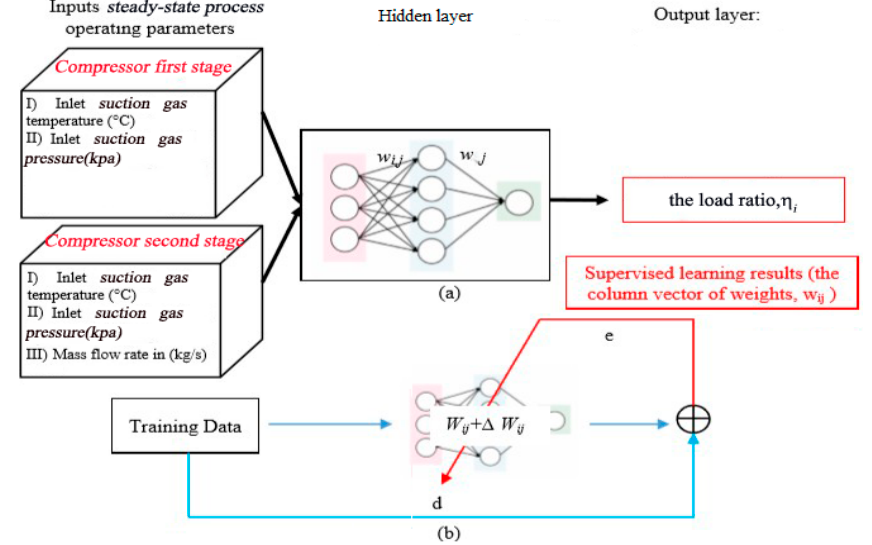
Figure 16. Prediction model structure diagram. ( a ) three-layer artificial neural network model; ( b ) the training process.